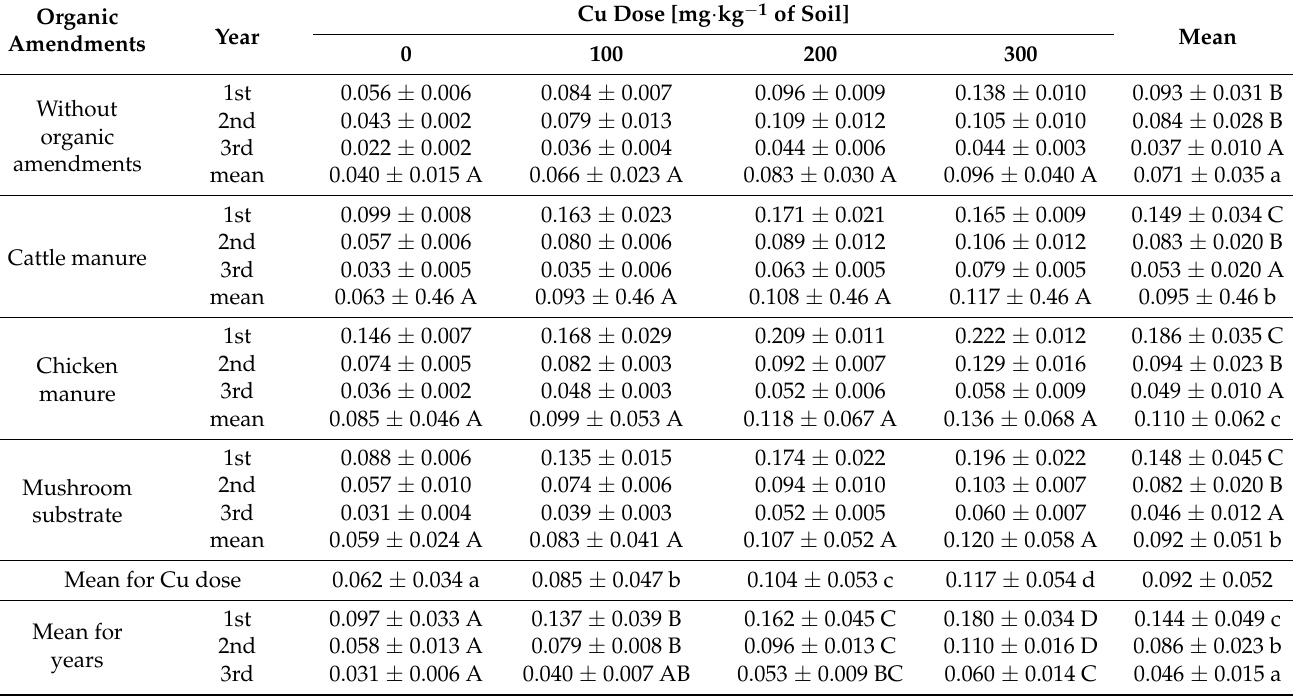
Table 4. Amount of copper uptake by cocksfoot, mg Cu · pot − 1 (mean ± SD).